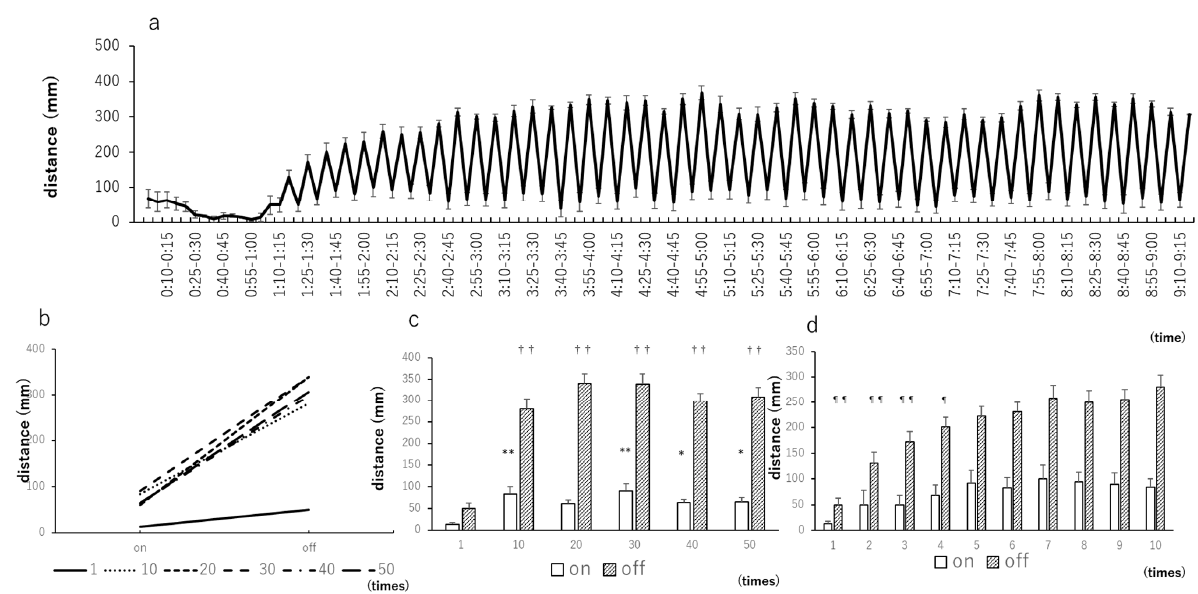
Figure 3. Light–dark test with 5-min intervals repeated 50 times. ( a ) Distance traveled by zebrafish larvae when light and dark stimuli were alternately repeated 50 times at 5-min intervals after being acclimated to a dark place for 1 h. As the number of repetitions increases, the traveled distance becomes smaller and more constant; ( b ) distance when the light is on and off at arbitrary numbers of repetitions (1st, 10th, 20th, 30th, 40th, and 50th). At all points, the traveled distance is larger when the light is off than when the light is on. After the 10th repetition, there are almost no changes in the traveled distance; ( c ) Tukey–Kramer test results; ( d ) Dunnett’s test results, where the 1st to 10th repetitions were extracted and tested using the 10th repetition as reference. * p < 0.05 vs. 1 (on), ** p < 0.01 vs. 1 (on), † p < 0.05 vs. 1 (off), †† p < 0.01 vs. 1 (off) (Tukey–Kramer test). ¶ p < 0.05 vs. 10 (off), ¶¶ p < 0.01 vs. 10 (off) (Dunnet’s test). Values are presented as mean ± SE ( n = 42).